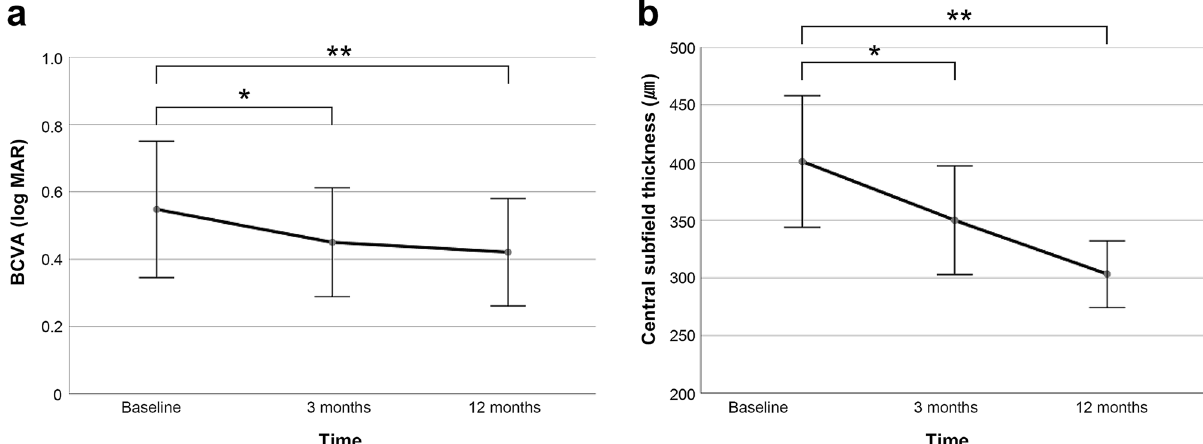
Figure 4. Changes in best-corrected visual acuity (BCVA) ( a ) and central subfield thickness ( b ) after focal laser photocoagulation in patients with a telangiectatic capillary in persistent diabetic macular edema. Error bars denote 95% confidence intervals. Asterisks indicate a statistically significant difference compared to baseline (*p < 0.05, **p <